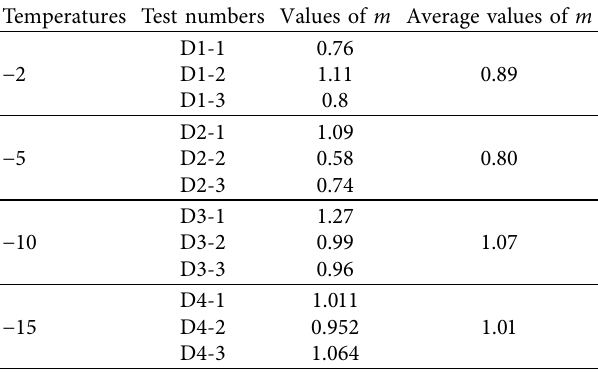
Table 4: The relationship between temperature and parameter m . Temperatures Test numbers Values of m Average values of m